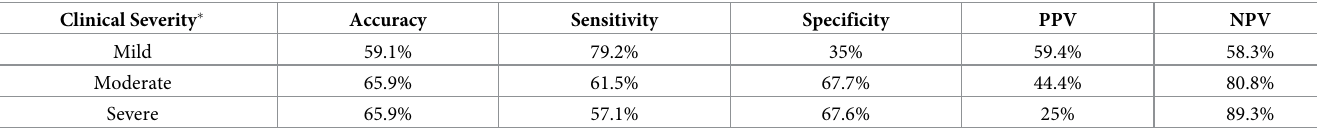
Table 4. Prediction of COVID-19 clinical severity by Rametrix 1 analysis of urine. Clinical Severity